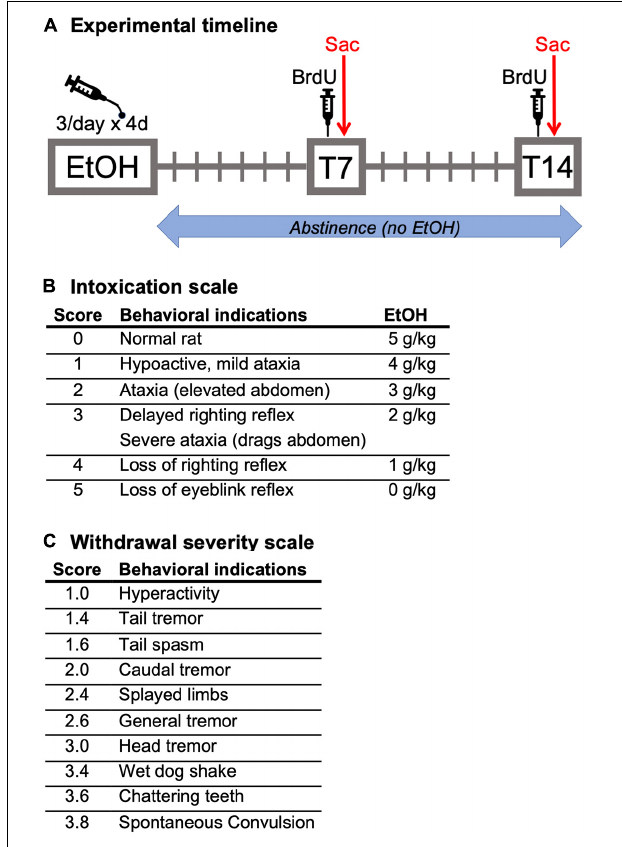
FIGURE 1 | (A) Experimental timeline: Following a 4-day binge alcohol exposure, female rats underwent abstinence for either 7 (BrdU, Ki67, Sox2, and Sox2/KI67 analysis) or 14 (BrdU, Ki67, NeuroD1, and Prox1 analysis) days in the home cage. Two hours prior to perfusion at both time points, all rats were injected with BrdU. (B) Intoxication behavior scale and dosing. (C) Withdrawal severity scale.